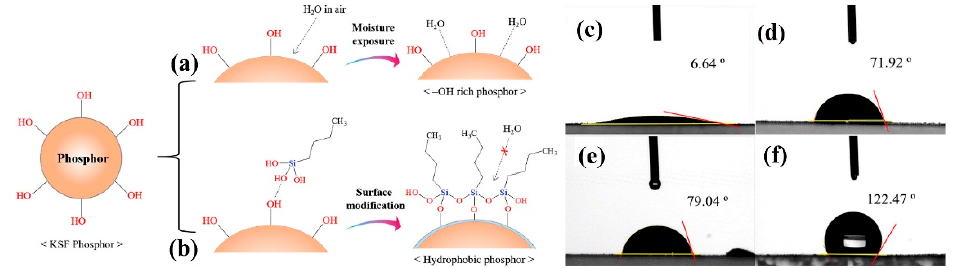
Figure 8. The formation mechanism of ( a ) adsorption of water and ( b ) moisture-proof layer on K 2 SiF 6 : Mn 4+ surface; water contact angle image of ( c ) KSF; ( d ) C3-KSF; ( e ) C6-KSF; ( f ) C16-KSF. (Reprinted from Ref [37]. Copyright from Elsevier, 2017).